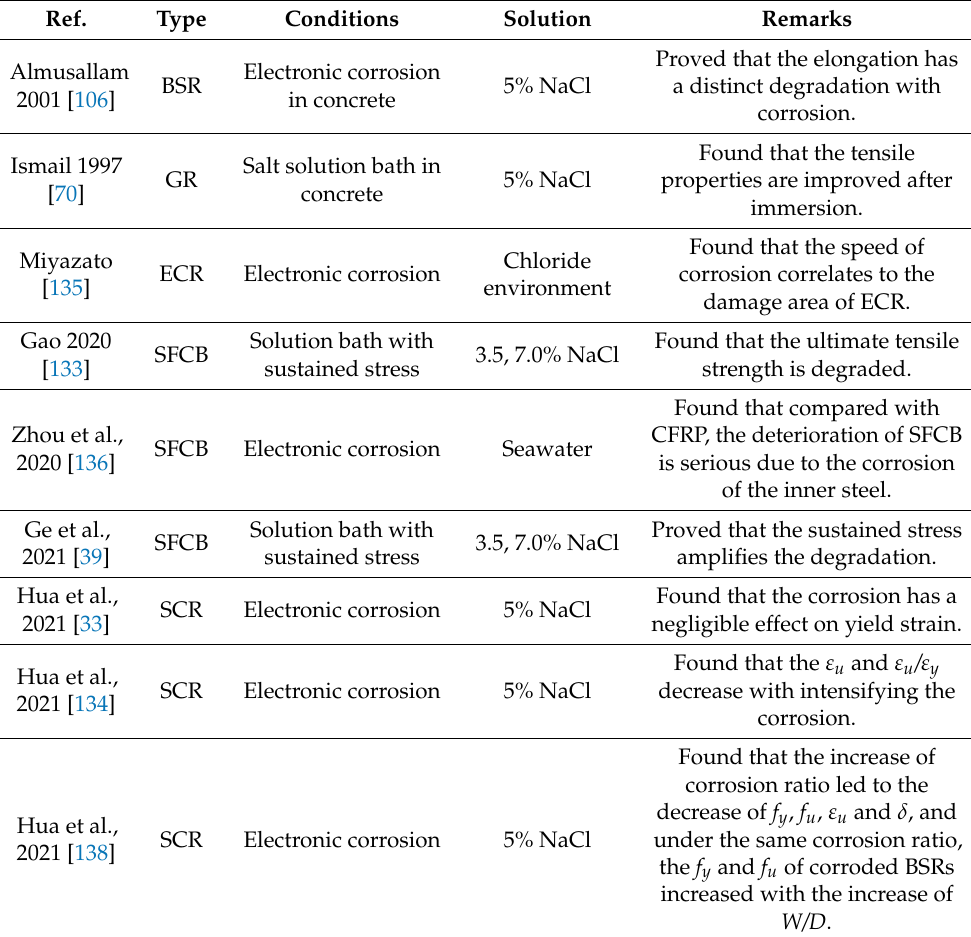
Table 6. Experiments on corroded fatigue properties of GR and SCR.